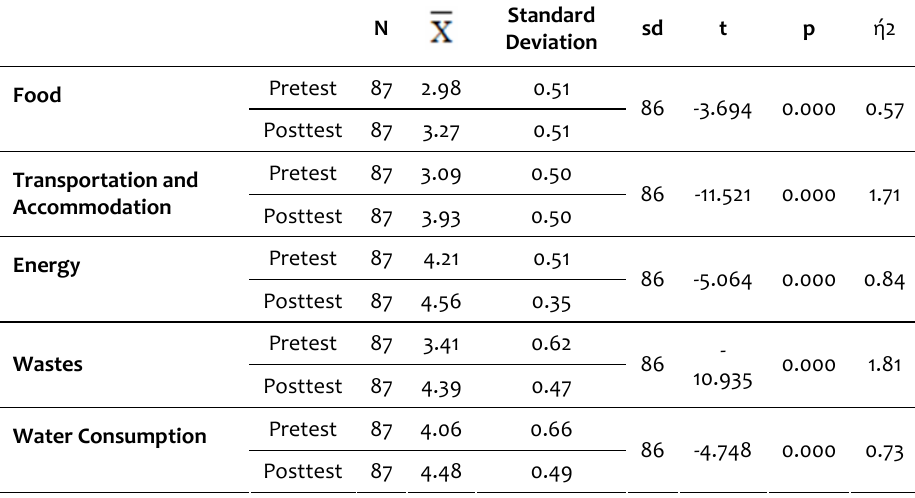
Table 5. Comparison of the average scores obtained from the pre-post test ecological footprint awareness scale with the dependent groups t-test N